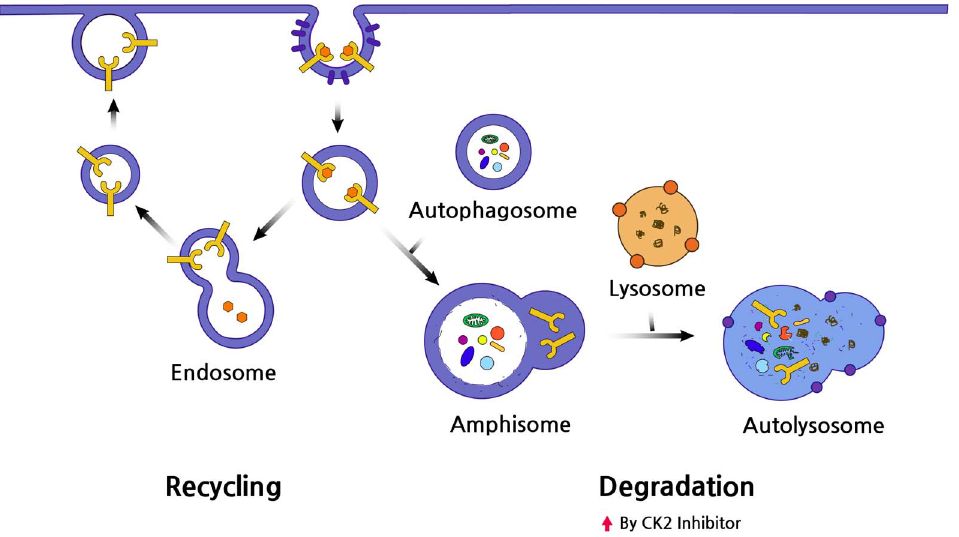
Figure 6. Illustration of EGFR degradation by CX-4945-induced authophagy. EGFR is delivered from the plasma membrane to early endosomes in endocytic vesicles. These vesicles are back to the plasma membrane through the recycling pathway. However, vesicles can also fuse with authophagosomes, and then directly with lysosomes leading to degradation of